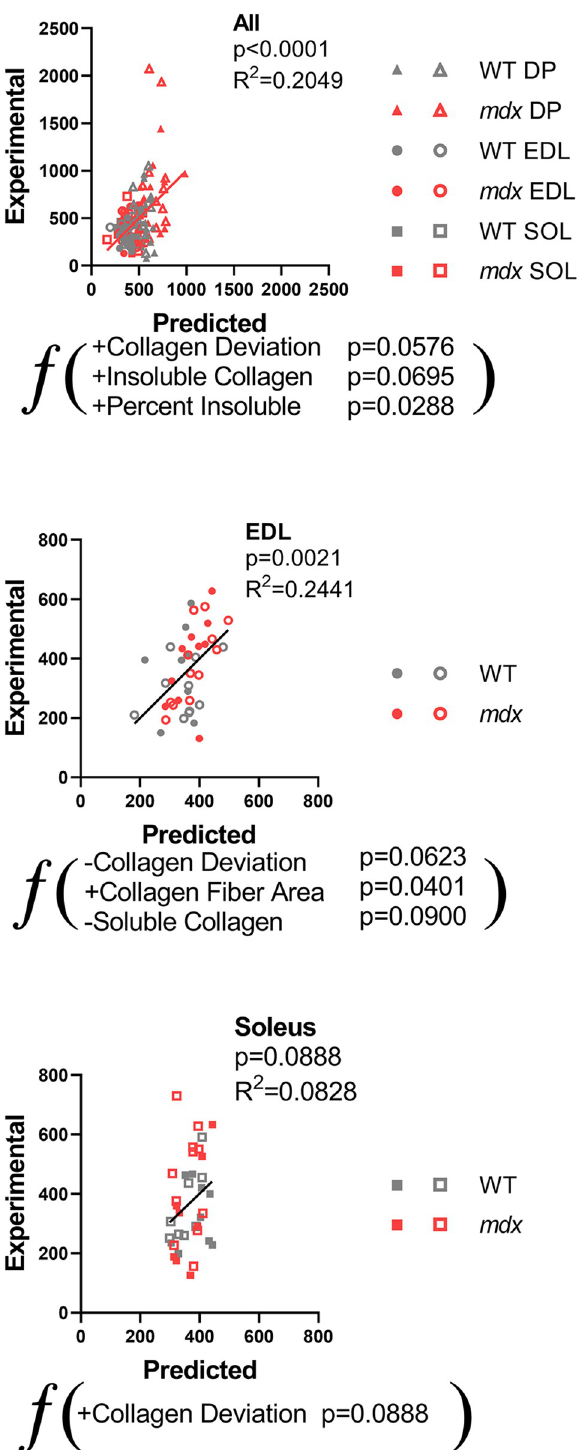
Fig 5. Multiple linear regressions for elastic stiffness. Aspects of collagen architecture predict elastic stiffness across muscles and within EDL and soleus. (A) A multiple linear regression model was run in MATLAB to predict elastic stiffness across all muscles and individually within each muscle. The model produced significant predictors collagen deviation, insoluble collagen, and percent insoluble. (B) Collagen deviation and soluble collagen were negative predictors and collagen fiber area was a positive predictor of EDL elastic stiffness. (C) Collagen deviation was a positive predictor of elastic stiffness in the soleus. https://doi.org/10.1371/journal.pone.0271776.g005 PLOS ONE | https://doi.org/10.1371/journal.pone.0271776 October 27,